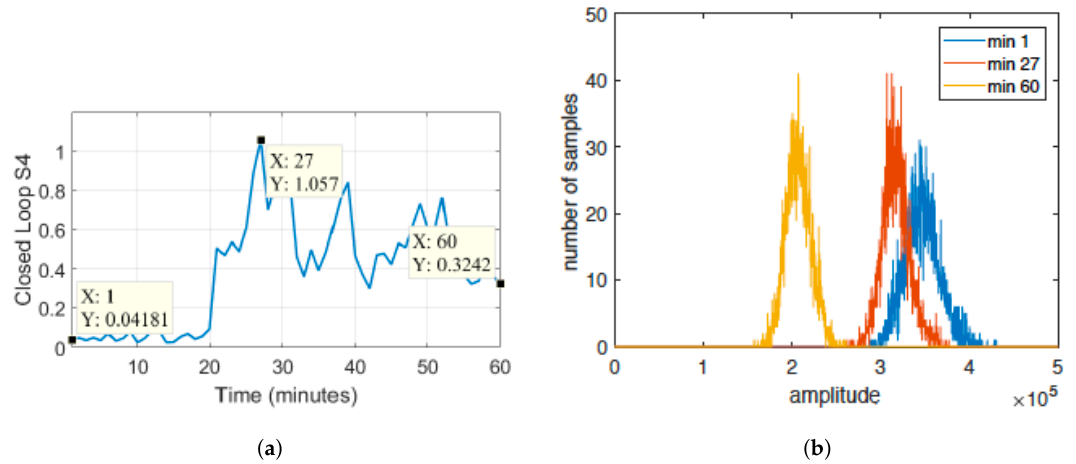
Figure 1. The distribution of the signal samples varies according to scintillation intensity; ( a ) values of the amplitude scintillation index S 4 over time; ( b ) histogram of the Signal Intensity (SI) for three different values of amplitude scintillation taken at three different time